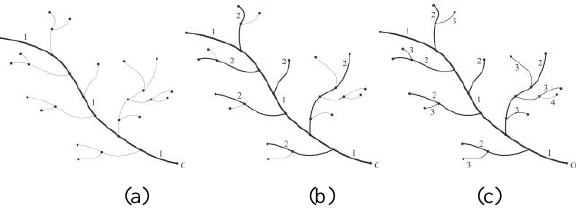
Figure 4. Procedures of automated coding system for dendritic river systems: (a) coding the main stem, (b) coding of tributaries and (c) final results of stream